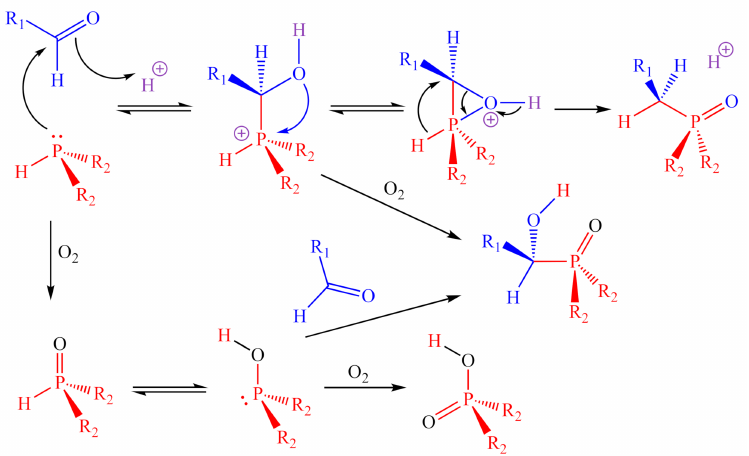
Figure 7. Proposed mechanisms for the ARC synthesis, as well as for the observed side